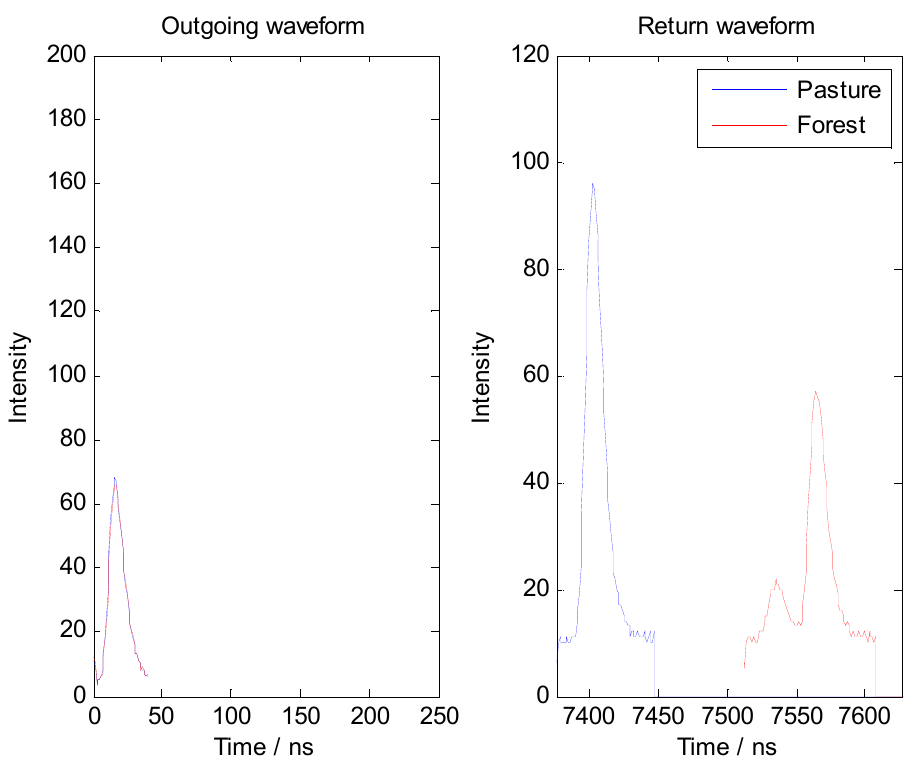
Figure 2. Raw waveform data recorded from two pulses over open pasture and forest